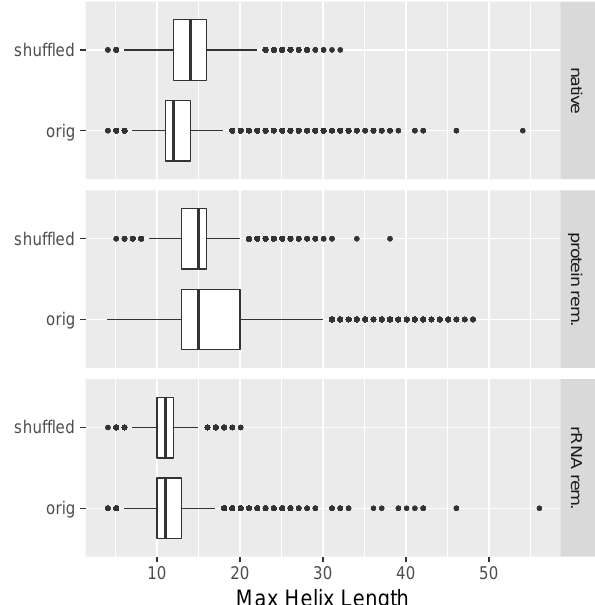
Figure 5. Evidence that co-expressed sequences are under constraints to avoid non-specific RNA–RNA interactions. Compared are shuffled and unshuffled read sequences. The maximum helix length read–read interactions for any given read (as predicted from RNAduplex) are plotted for different treatments. One can see that, for native cell lysates, shuffled sequences led to longer maximum contiguous helix lengths compared to the unshuffled case. For protein-removed datasets, the maximum helix lengths were longer and no substantial differences between shuffled and unshuffled sequences were observed.